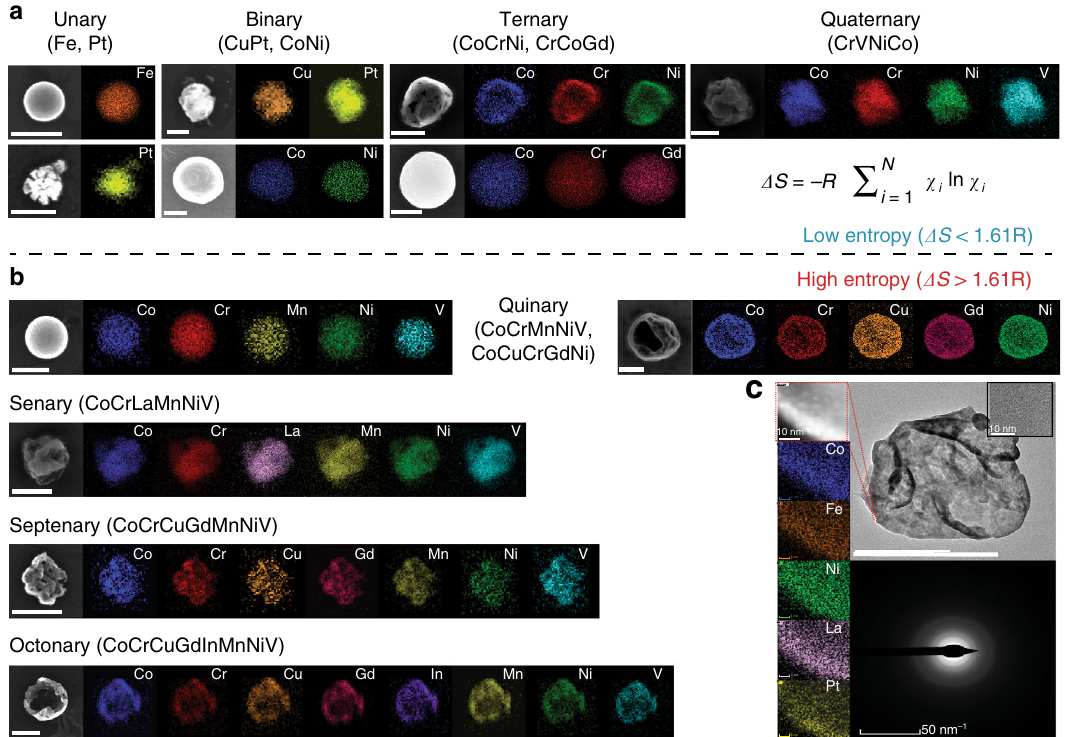
Fig. 2 Elemental and microstructural characterization of alloy NPs with up to eight components. a EDX maps of various low-entropy MG-NPs. A low- entropy classi fi cation is dictated by <4 elemental components with equimolar stoichiometric ratios to give a Δ S < 1.61 R. b EDX images of HEMG-NPs ( Δ S > 1.61 R) produced by adding up to eight metal salt precursors to the nanodroplets. c HAADF-STEM images of a CoFeNiLaPt HEMG-NP with accompanying high-resolution EDX images showing disordered elemental distribution at the atomic scale. The diffuse rings on the SAED pattern indicate an amorphous microstructure. All NPs were electrodeposited at − 1.5 V vs. Ag/AgCl. Scalebars represent 500 nm unless otherwise